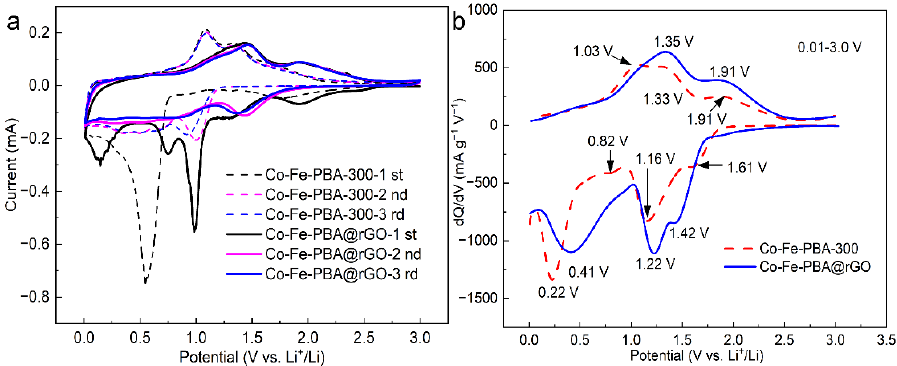
Figure 4. ( a ) CV curves for Co-Fe-PBA-300 and Co-Fe-PBA@rGO for the first 3 cycles at a 0.1 mV s − 1 scan rate and 0.01–3.0 V voltage vs. Li + /Li; ( b ) dQ/dV curves (Q, capacity; V, voltage) vs. the initial discharge–charge profiles for fabricated Co-Fe-PBA-300 together with Co-Fe-PBA@rGO at a 0.1 A g − 1 current